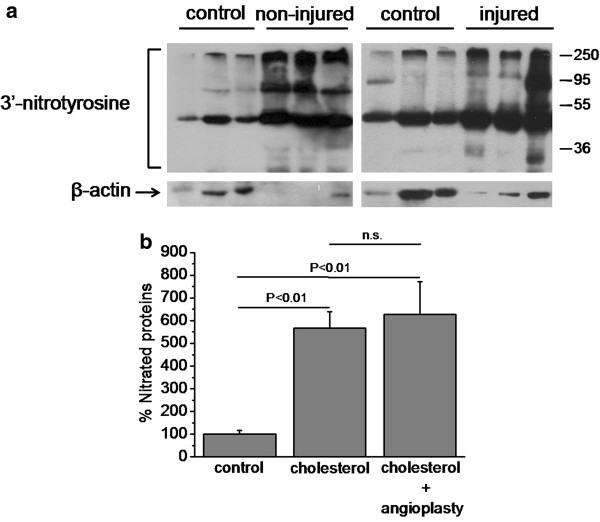
Tyrosine nitration of proteins is not increased by the transauricular balloon angioplasty. a. Western Blot analysis for 3′-nitrotyrosine (upper panel) and β-actin (lower panel) in total protein lysates of descending aortas. b. The protein amounts were quantified by densitometric analysis of the corresponding bands and the ratio of nitrated proteins/β-actin was calculated for each lane. Results are expressed as mean ± S.E.M. of the percentage change of the amounts of 3′-nitrotyrosine compared with control animals. n.s, not statistically significant.